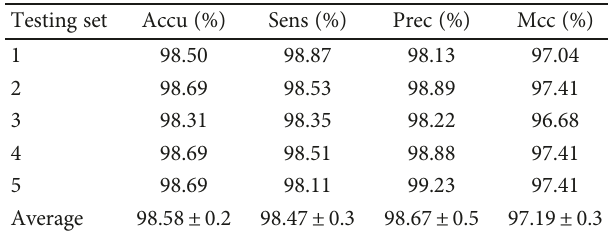
Table 1: 5-Fold cross-validation results using the proposed method on the human dataset.